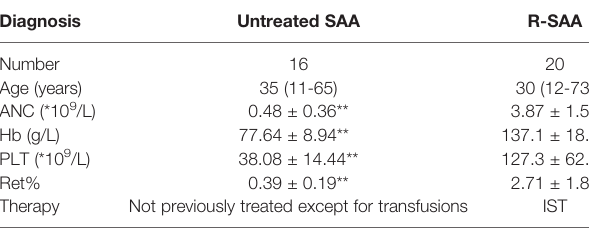
TABLE 1 | The clinical characteristics of all the patients.